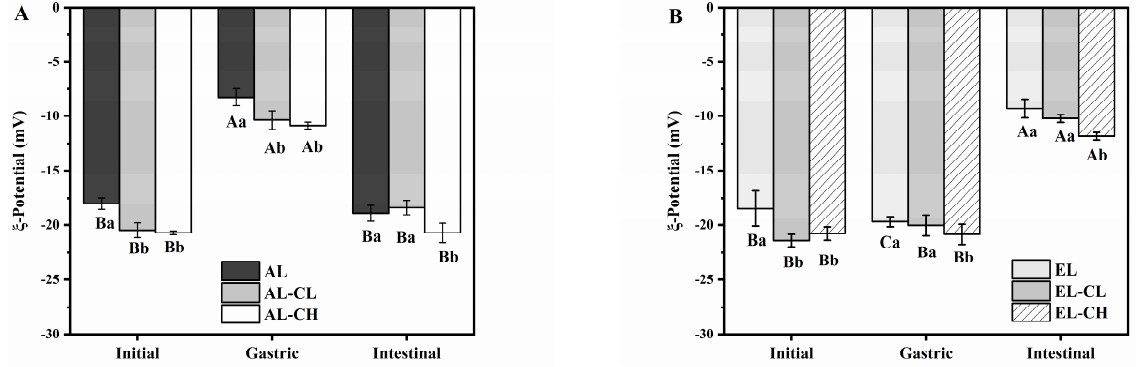
Figure 3. Zeta-potential of initial emulsions and emulsions after different digestion stages of ( A ) adult and ( B ) infant. Data were shown as mean ± SD of three replicates. A-C Different capital letters indicated significant differences ( p < 0.05) in the same group (with same legend) at initial, gastric, and intestinal stages of digestion. a-c Different lowercase letters indicated significant differences ( p < 0.05) among different groups (with different legends) at the same stage of digestion. The same letter indicated no significant difference ( p > 0.05).